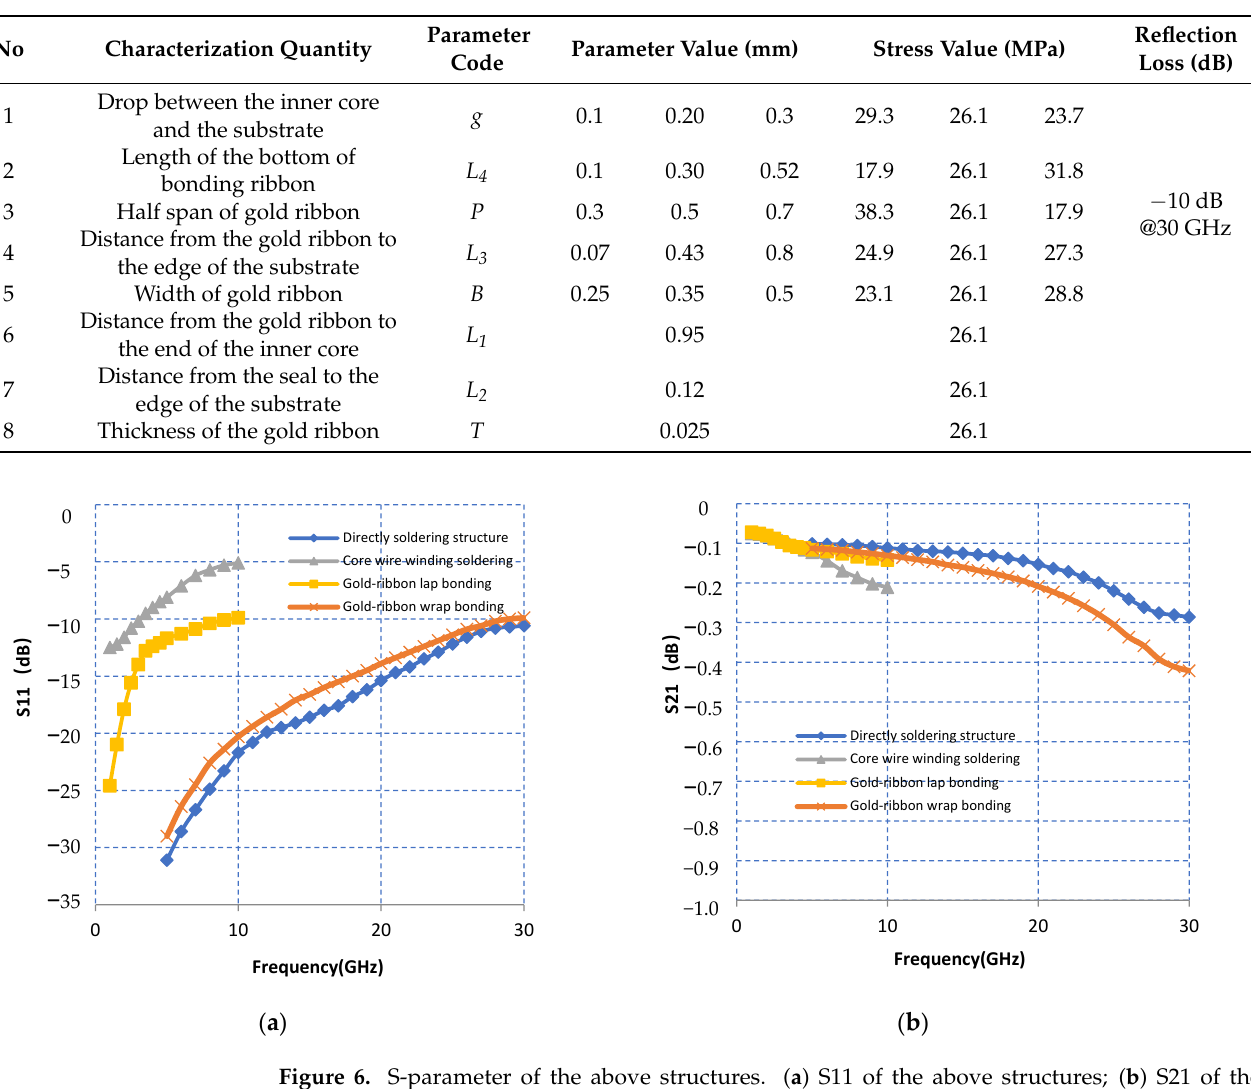
Table 2. Parameters and analysis results of gold-ribbon wrap bonding.